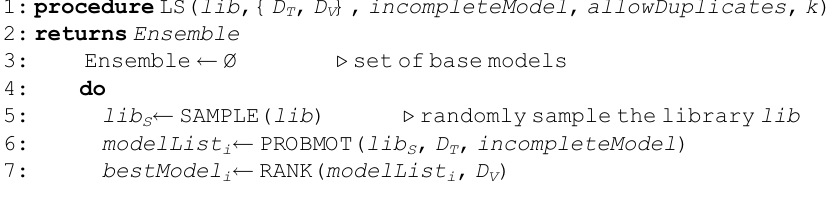
Algorithm 1 Learn ensembles of process-based models via library